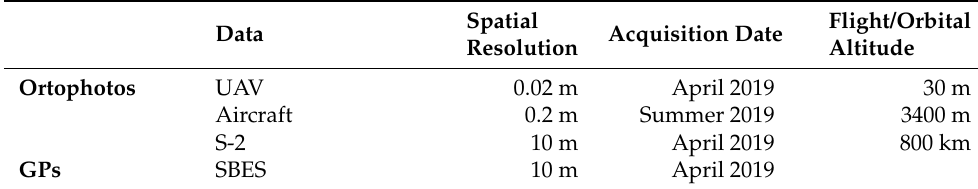
Table 1. Dataset description: spatial resolution and acquisition dates of orthophotos and GPs for Capo San Donato.